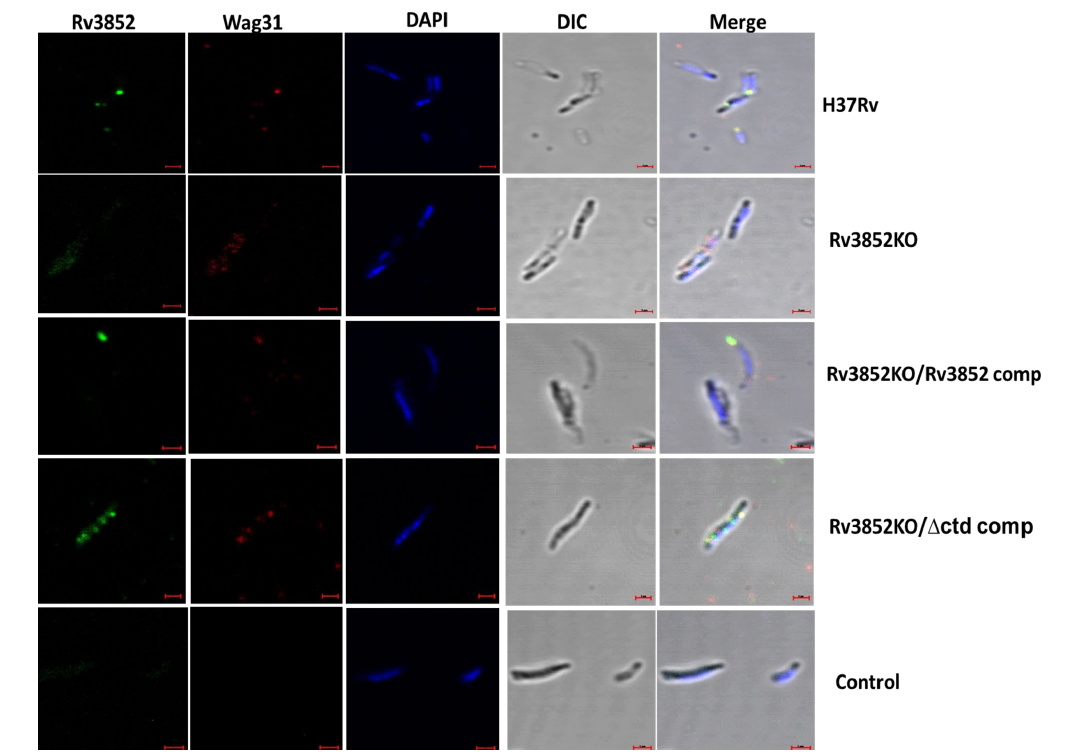
Figure 5. Mislocalization of Wag31 in absence of Rv3852 in Mtb. First and second panels show representative confocal images showing co-localization of Rv3852 (green) and Wag31 (red) at one or both poles of Mtb H37Rv and mislocalization of Wag31 in Rv3852KO, respectively. Third panel shows co-localization between Rv3852 and Wag31 in Rv3852KO/Rv3852 comp. Fourth panel shows diffused distribution of Rv3852 ∆ ctd and Wag31. Pre-immune sera were used as negative control (last panel). The last lane of each panel shows merged image from all the channels. The images were acquired using a Zeiss LSM880 microscope under 100 × objective with 2 × zoom. Scale bar indicates 1 µ m. See Figure S5 for fluorescence intensity distribution